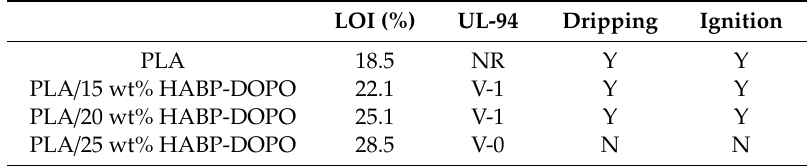
Table 1. The limiting oxygen index (LOI) values and vertical burning (UL-94) rating of PLA and its